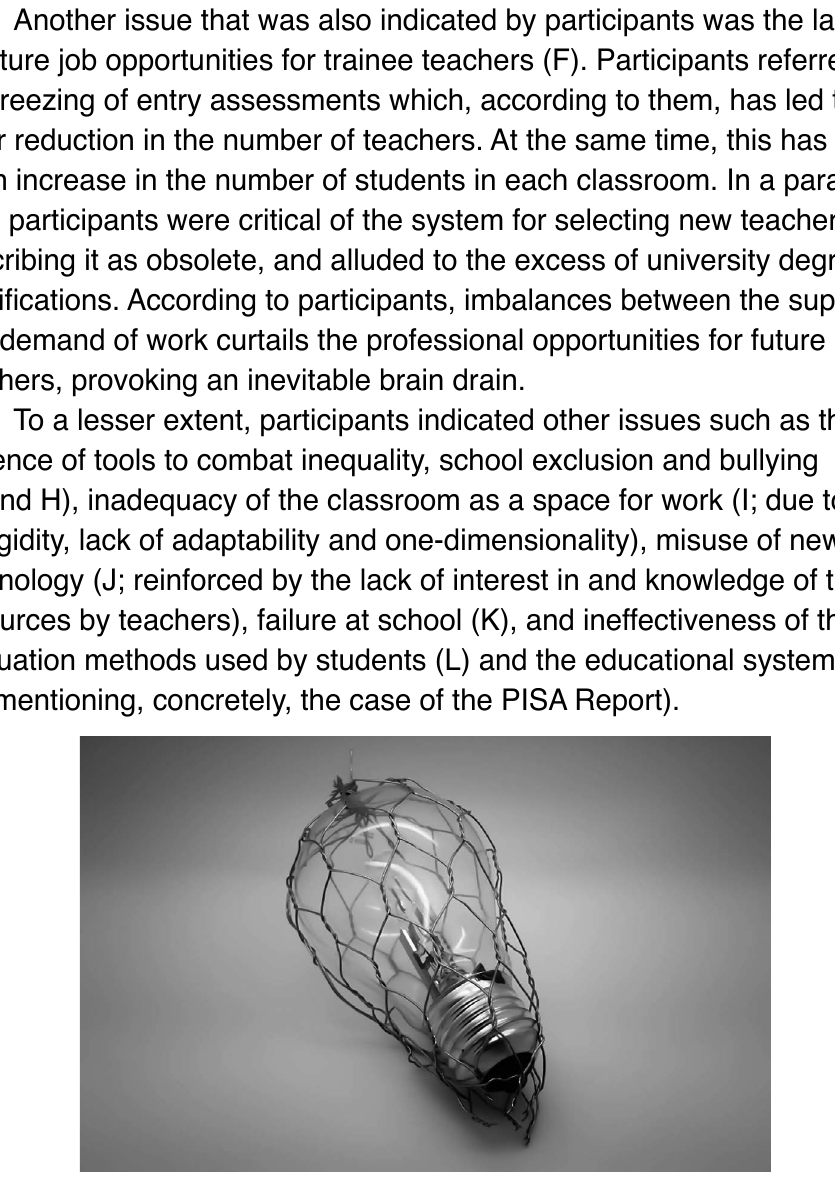
Figure 3. Ignacio Raga (2017), Apresada [Captured]. Photograph taken by a student that criticises the lack of concern shown for the development of skills such as creativity and critical thinking. © I. Raga. Primary Education student. Bachelor’s degree student in Primary